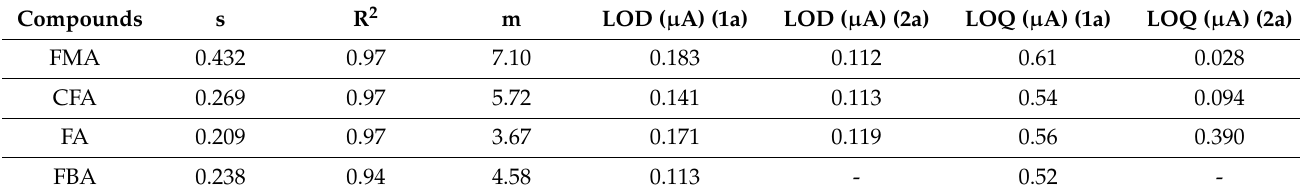
Table 4. The values of LOD and LOQ calculated for all